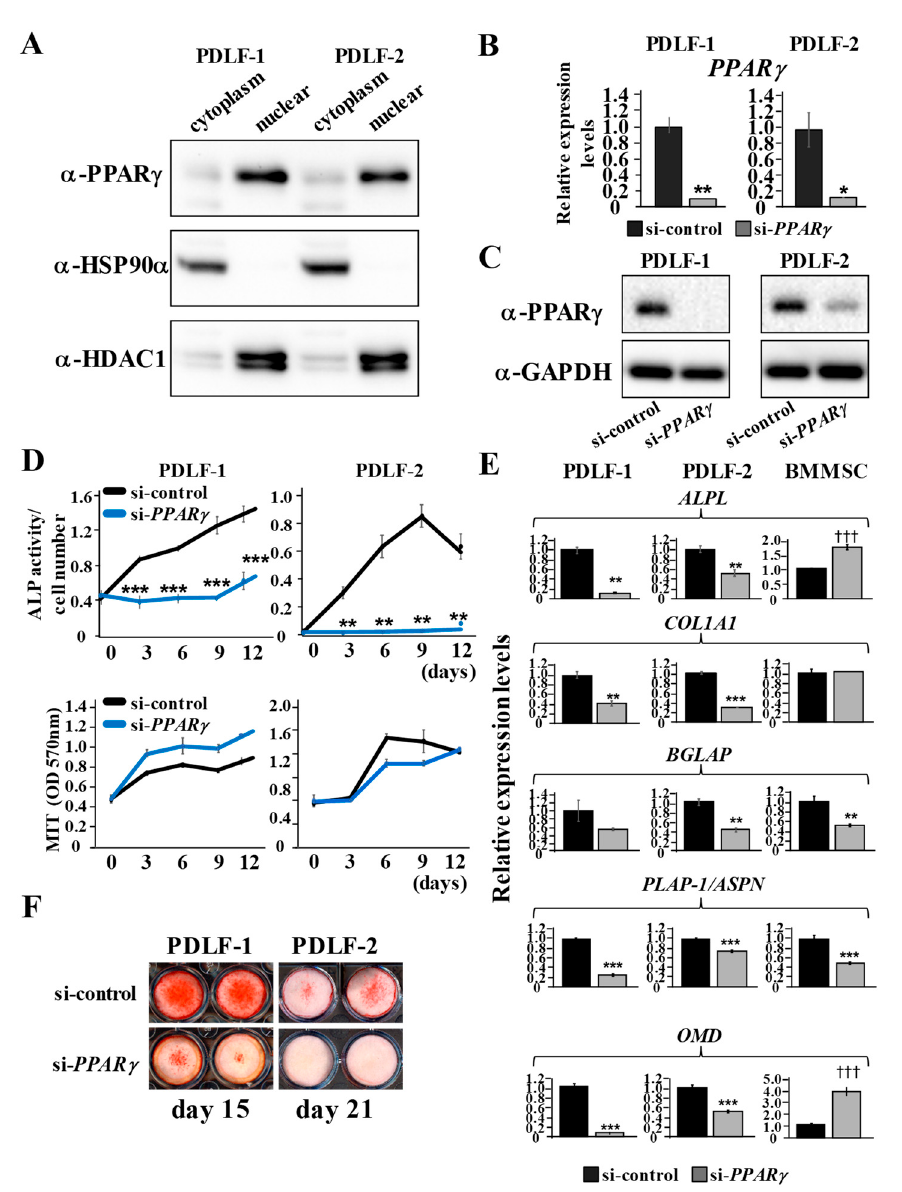
Figure 3. Suppression of PPAR γ expression eliminates osteo/cementogenic abilities of PDLF . ( A ) Cytoplasmic and nuclear fractions were isolated separately from PDLF-1 and PDLF-2 and loaded onto SDS-PAGE gels. ( B – F ) PDLF-1 and PDLF-2 were transfected with si-control or si- PPAR γ . ( B , C ) PPAR γ mRNA expression ( B ) and protein expression ( C ) 24 h after transfection was analyzed using HPRT for normalization ( B ) and GAPDH as the loading control ( C ). ( D ) ALP activities were measured and cell numbers were enumerated by MTT every 3 days. ALP activities were normalized by MTT values. ( E ) The gene expression levels of ALPL , COL1A1 , BGLAP , PLAP-1/ASPN , and OMD were examined on day 6 for PDLFs and on day 12 for BMMSC. ( F ) Alizarin red S staining was performed on day 15 for PDLF-1 and on day 21 for PDLF-2. Data represent the mean ± SD of three independent experiments. * p < 0.05; ** p < 0.01; *** p < 0.001 and ††† p < 0.001 significantly lower and higher in cells transfected in si- PPAR γ , respectively.